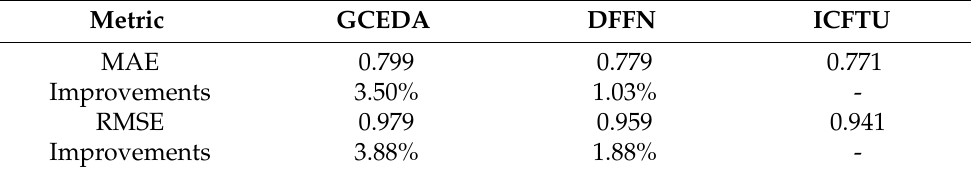
Table 5. The results of the compared experiment with other two recommendation approaches.